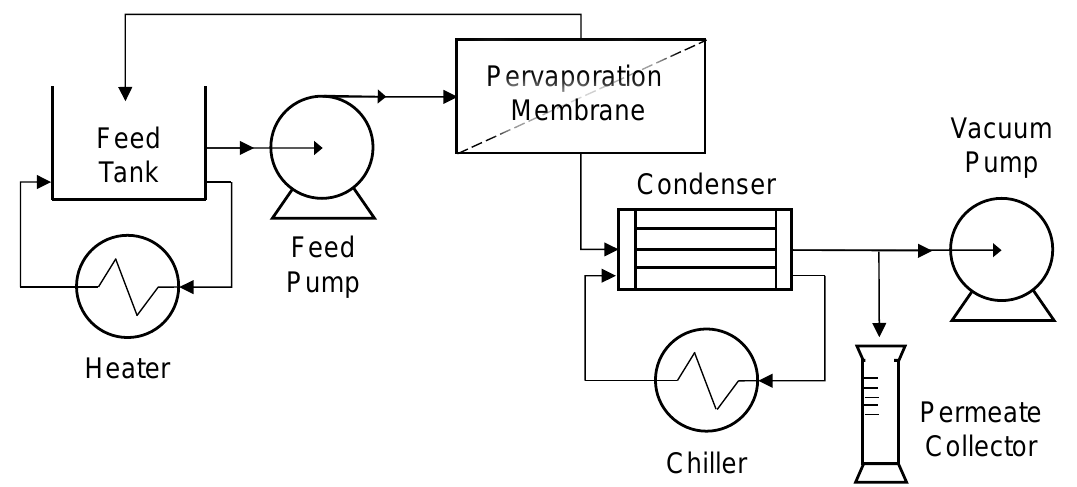
Figure 2. Schematic of the bench-scale PVD system.